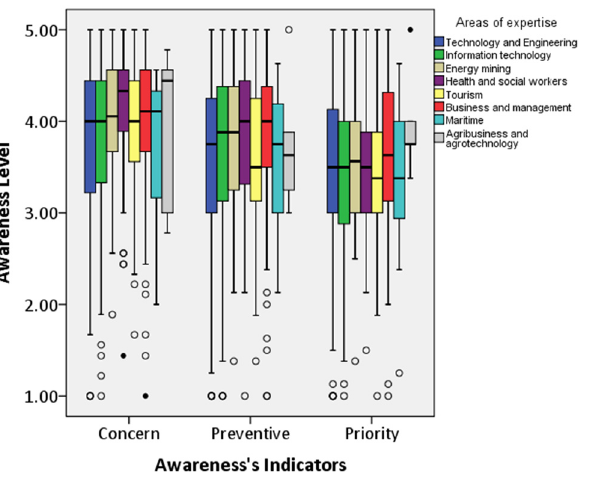
Figure 13: Student ’ s awareness level by areas of expertise at